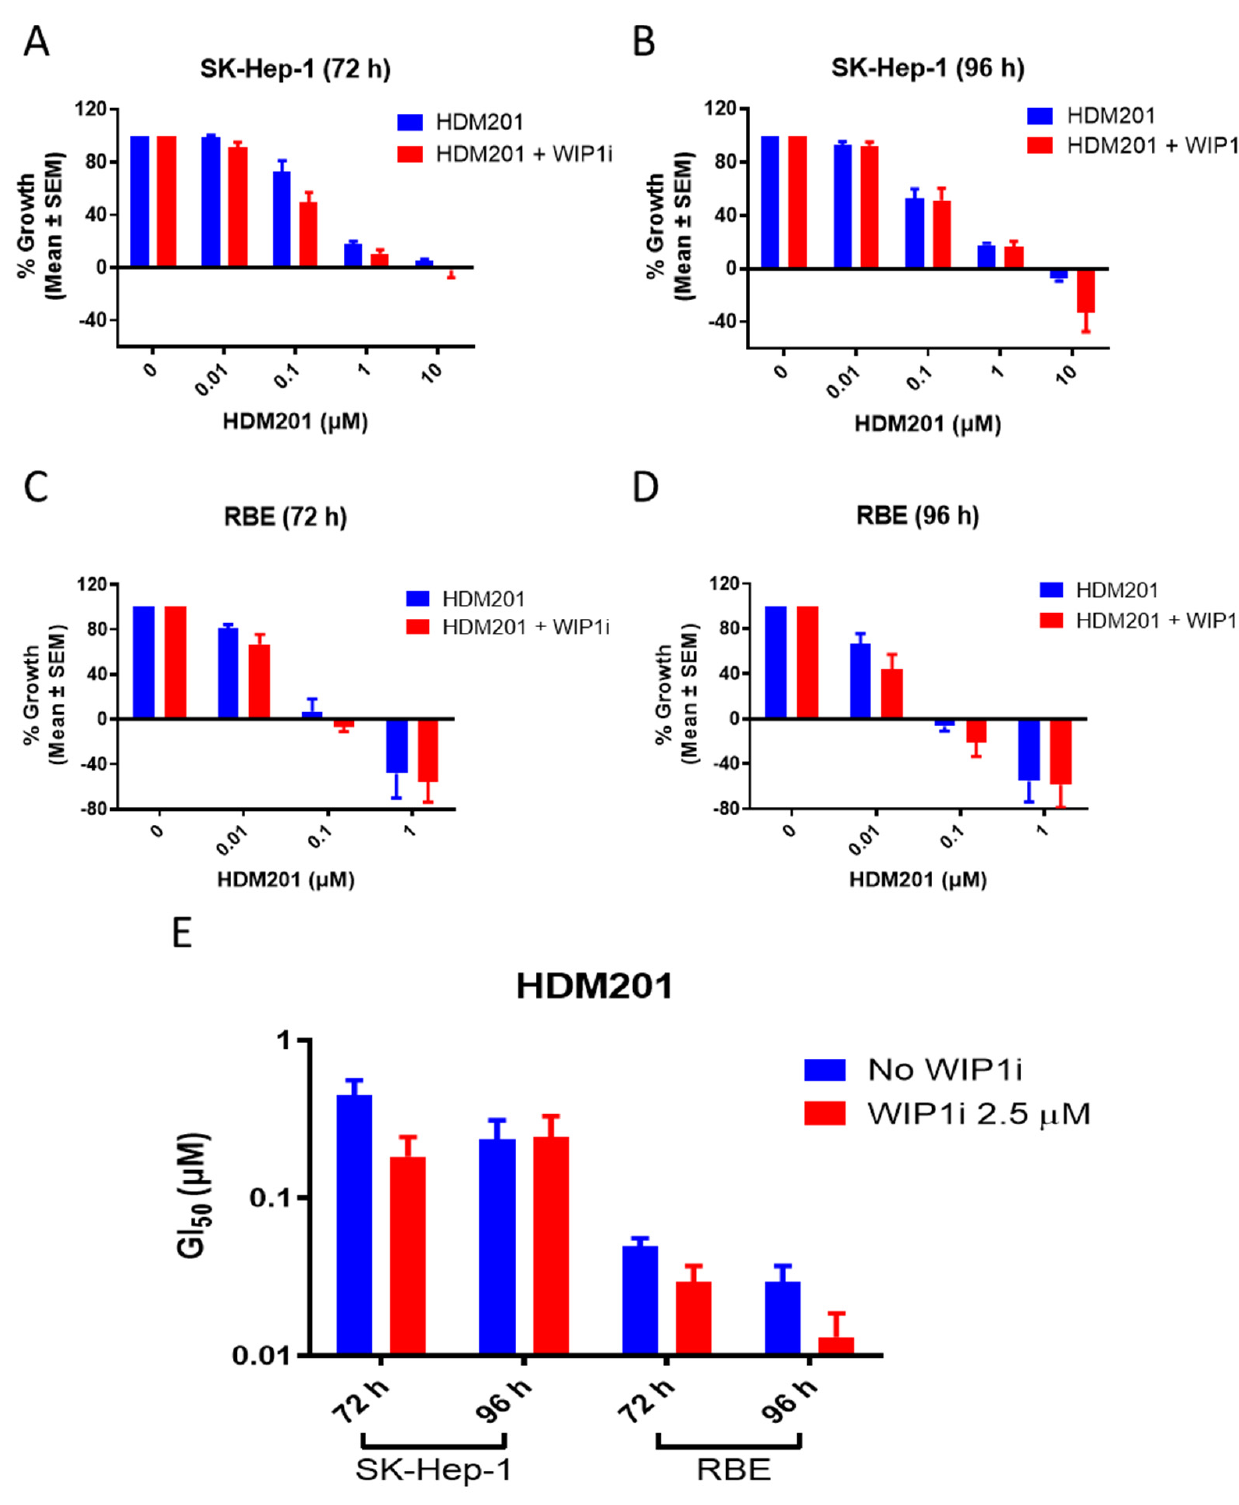
Figure 2. GSK2830371 potentiated the growth inhibitory activity of HDM201. SK-Hep-1 ( A , B ) and RBE ( C , D ) cells were treated with 0–10 µ M HDM201, either alone or in combination with 2.5 µ M WIP1 inhibitor (WIP1i) in 0.5% DMSO for 72 ( A , C ) or 96 ( B , D ) h. The growth rate of HDM201 + WIP1i was normalized against that for cells treated with 2.5 µ M WIP1i for 72 and 96 h, respectively. ( E ) Summary of half-maximal growth inhibitory concentration (GI 50 ) for HDM201 alone or in combination with WIP1i. GI 50 values were normalized against those for WIP1i. All data represent the mean ± SEM from three independent experiments performed in duplicate.